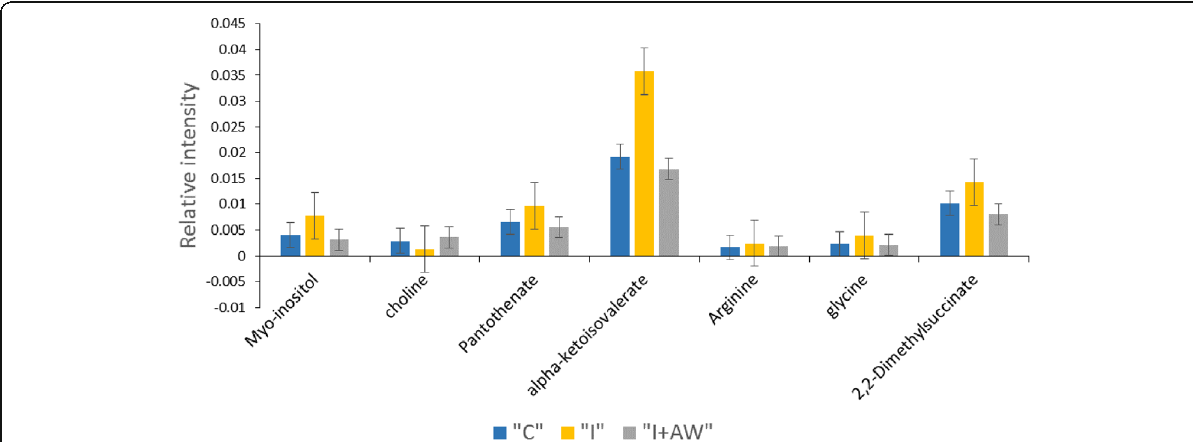
Fig. 9 Levels of 7 serum metabolites reversed nearly to control values after treatment with AW extract. The Y-axis represents relative peak intensities of the NMR spectra. ( “ C ” : control group, “ I ” : rats with indomethacin-induced gastric ulcer, “ I + AW ” : ulcerated rats treated with AW extract). Values are shown as mean ±